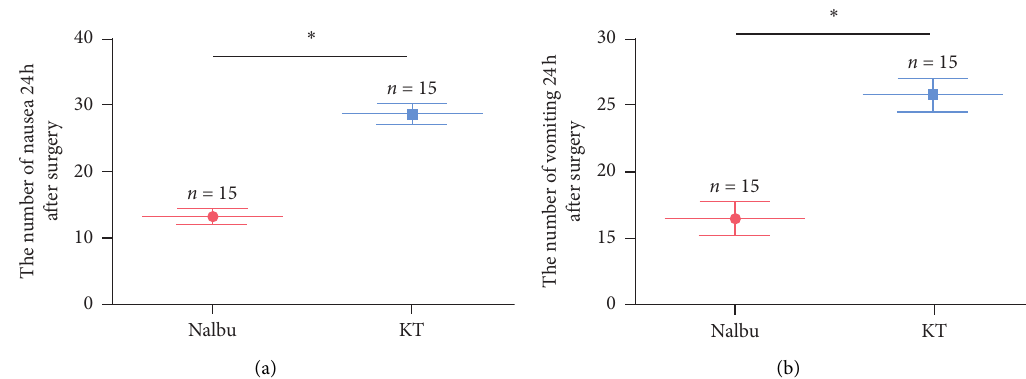
Figure 6: The number of nausea and vomiting 24h after surgery. (a) The number of nausea 24h after surgery; (b) the number of vomiting 24h after surgery. Nalbu, nalbuphine; KT, ketorolac tromethamine; (h) hours. n � 15 for each group, ∗ P < 0 . 05.